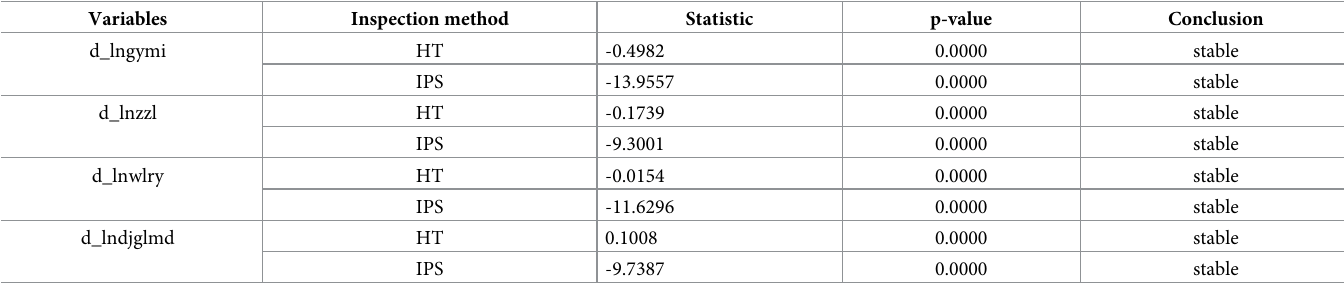
Table 12. Description of unit root test results of variable first-order difference